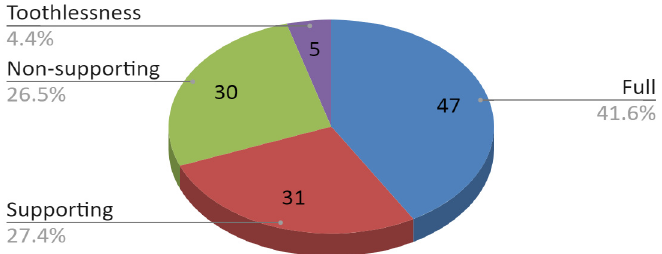
Figure 4. Dentition status of the patients. Figure 5. The correlation between the age of the patients and their dental condition. Description in the text.